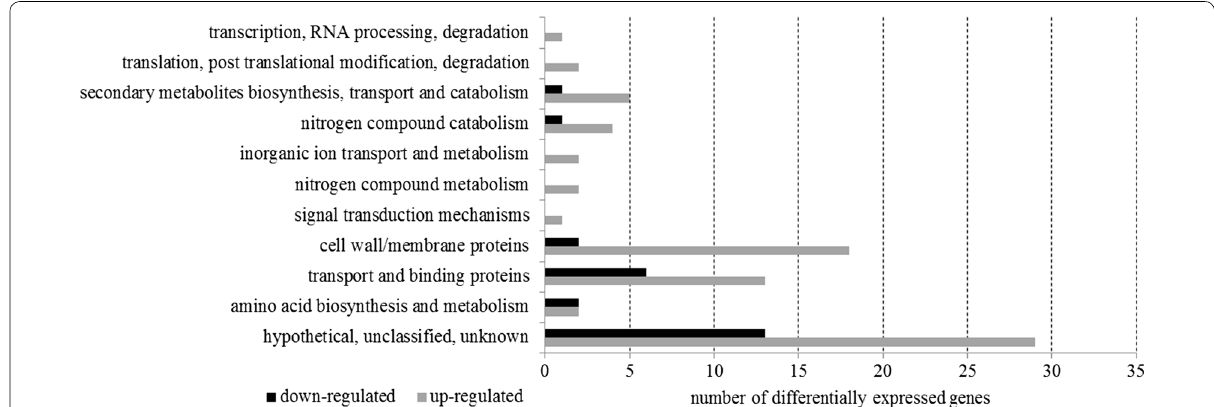
Fig. 5 Gene ontology analysis of the significantly differentially expressed genes between exponential growth and stationary phase of P. putida KT2440 relA / spoT mutant